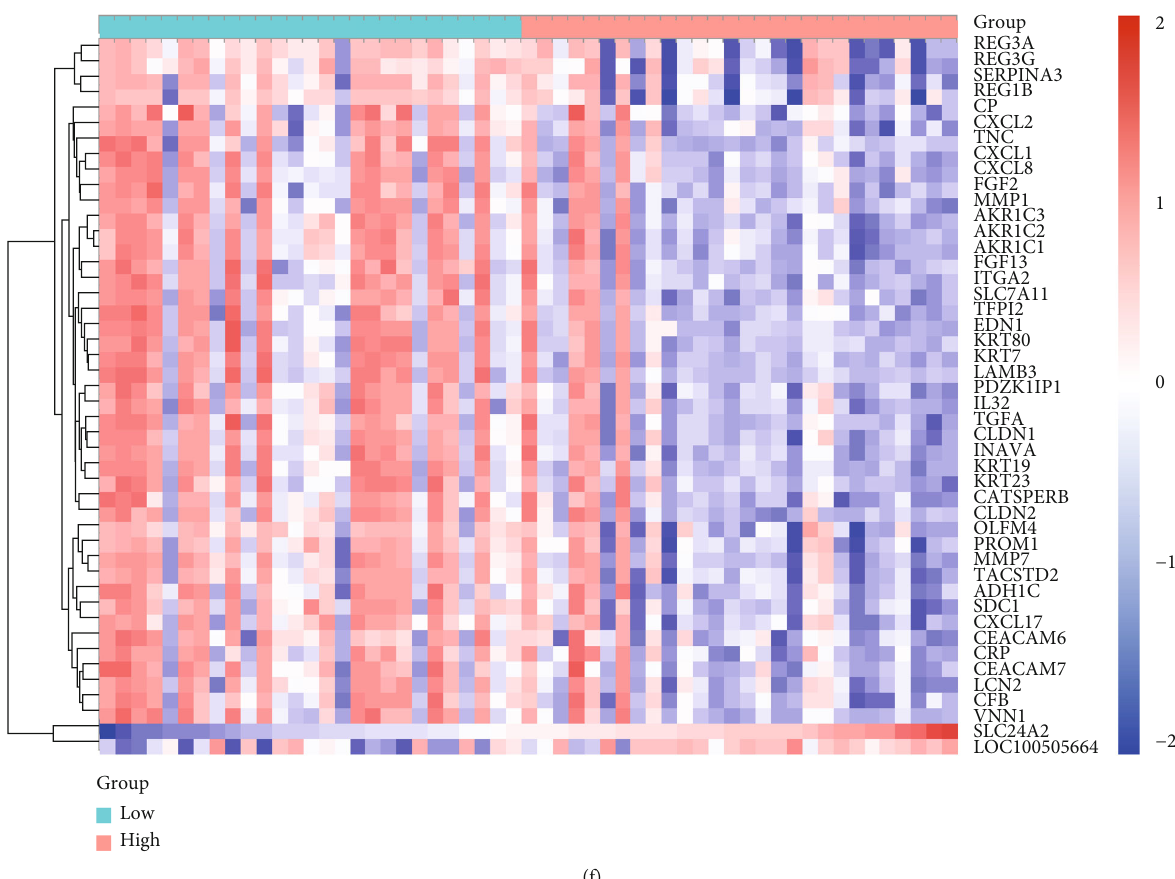
Figure 1: Identi fi cation of di ff erentially expressed genes. (a) SLC24A2 is upregulated in T2D ( logFC = 1 : 023 , P = 3 : 01 e − 03 ). (b) SLC24A2 is negatively correlated with fasting plasma glucose. (c) Volcano plot of the T2D verse control, red is the upregulated gene, blue is the downregulated gene, and black is not a signi fi cantly di ff erentially expressed genes. (d) Heatmap of di ff erentially expressed genes with j logFC j > 1 : 5 in T2D verse control. (e) Volcano plot of SLC24A2 -high verse SLC24A2 -low, red is the upregulated gene, blue is the downregulated gene, and black is not a signi fi cantly di ff erentially expressed genes. (f) Heatmap of di ff erentially expressed genes with j logFC j > 1 : 5 in SLC24A2 -high verse SLC24A2